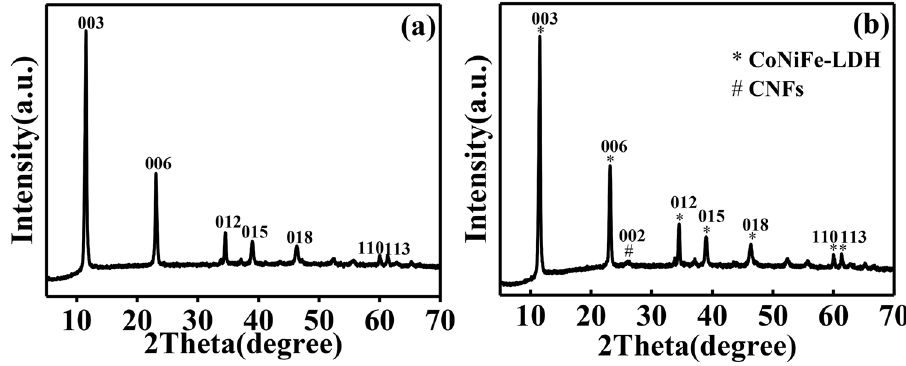
Figure 1. XRD patterns of ( a ) pure CoNiFe-LDH and ( b ) the CoNiFe-LDH/CNFs-0.5